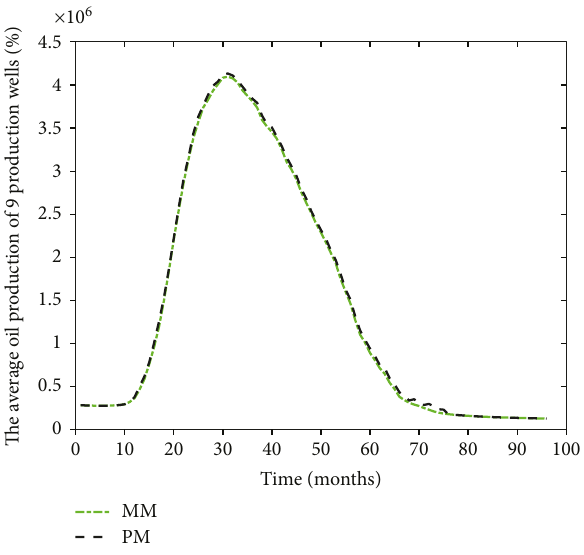
Figure 15: The average oil production comparison of 9 production wells.